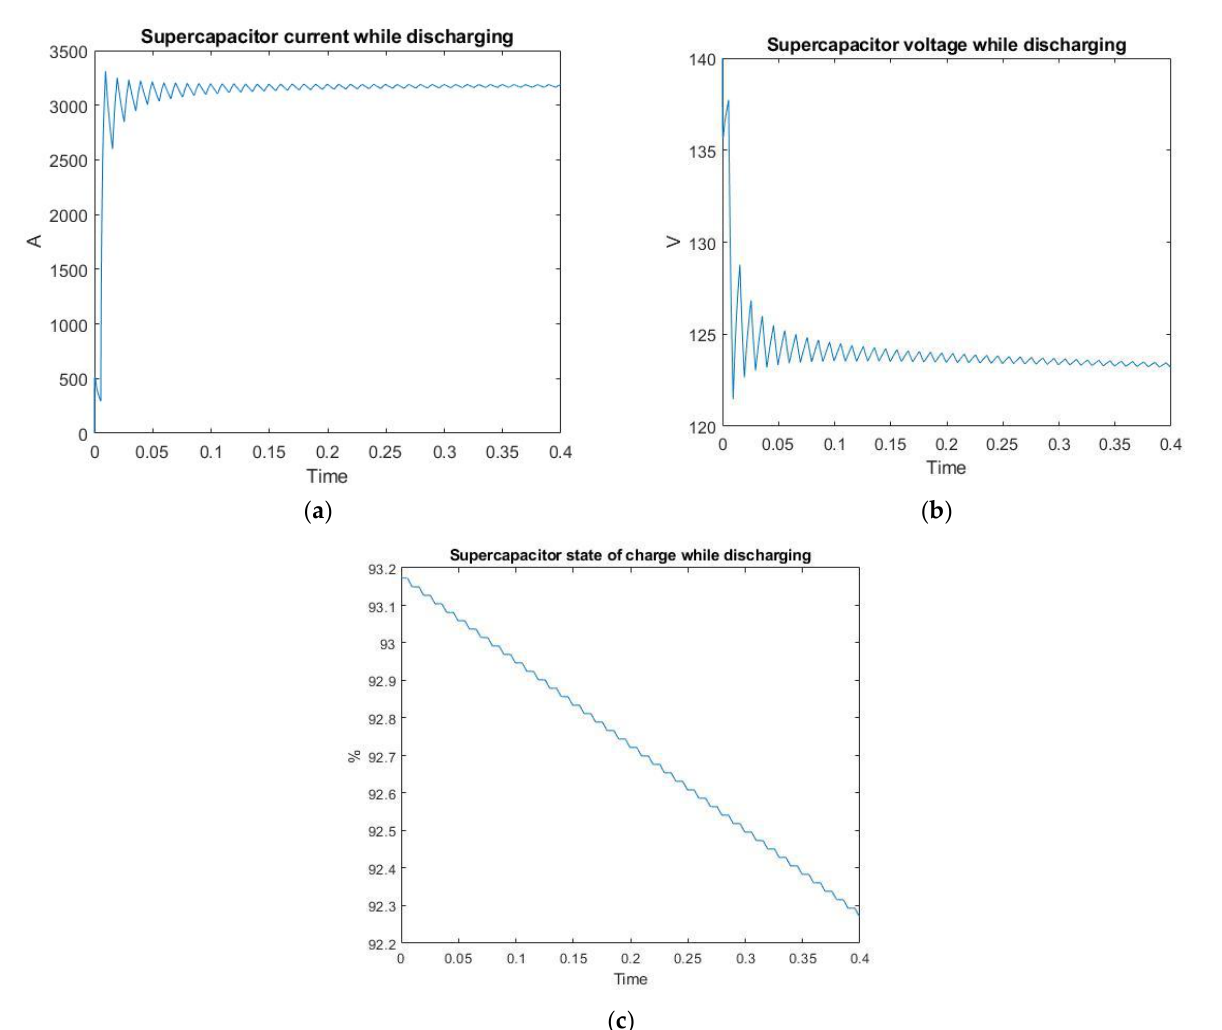
Figure 13. Discharge of a supercapacitor: ( a ) current; ( b ) voltage and ( c ) state of charge. The selected supercapacitor bank starts supplying 110 V to compensate for network losses. After simulation, a 100% charged supercapacitor bank will last about 50 s to supply buffer power to the network until it is fully discharged. This is sufficient since power was originally assumed to be supplied for 30 s. The analysis of the performance characteristics of the induction motor during super- capacitor bank charging shows that the time taken for the motor to reach steady state has increased by 0.05 s, which is 16.6% and is satisfactory for starting the motor under load. The overshoot during supercapacitor unit charging has increased from 14.2% to 25%, which also slightly affects the transient quality. In this case, the electrical characteristics of the motor—the rotor flux linkage and the stator current during charging have almost not changed. It can be concluded that the calculated supercapacitor bank, based on Maxwell BMOD0058 E016 B02, can be used as a buffer source of electricity in case of mains draw- downs up to 20%, as well as this unit can be charged from the mains in parallel with start- ing the motor at nominal mains voltage. A simulation was performed with the voltage dropping from 400 V to 320 V. The characteristics were recorded showing the change in voltage at the input of the rectifier and after the inverter (Figure 14).